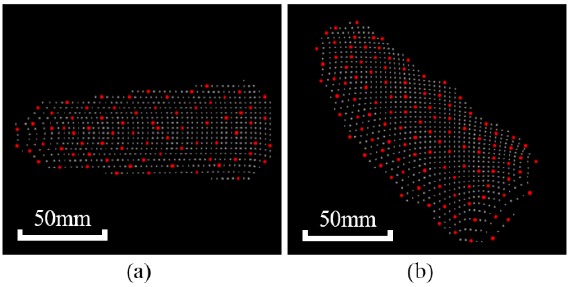
Figure 6. Key point extraction: ( a ) extraction result of the point cloud of the yarn bobbin template; ( b ) extraction result of the point cloud of the yarn bobbin to be captured. After generating the key points, the second step is to perform the point cloud alignment between the template and target point cloud. Point cloud registration is to use the yarn bobbin template point cloud to construct point-to-point features to find the yarn bobbin target in the actual scene and determine its 3D pose. The rigid transformation between the template point cloud and the target point cloud is the estimation process of target poses. The registration effects are shown in Figure 7.